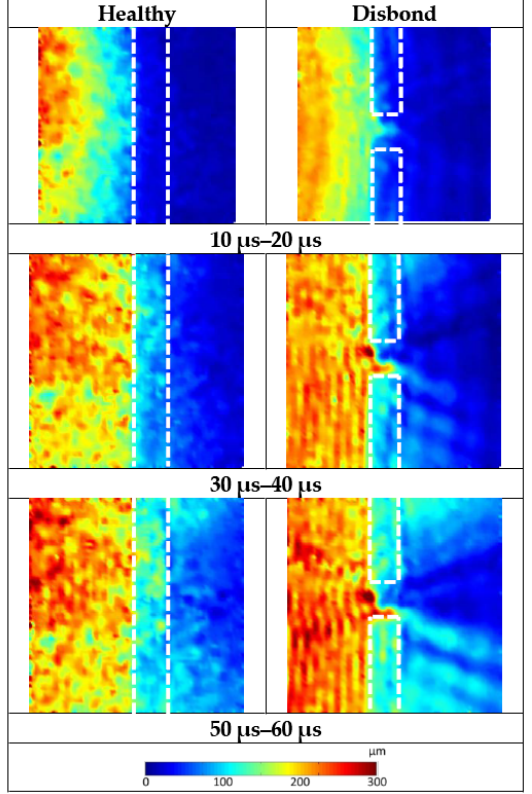
Figure 9. Windowed root mean-squared (RMS) plots of the three-component displacement magnitude for 100 kHz excitation.